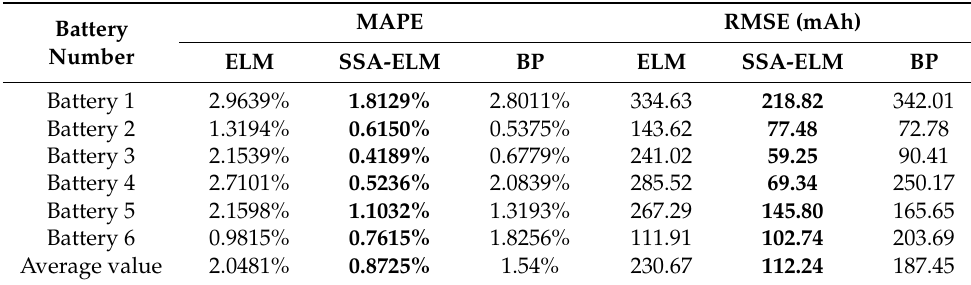
Table 3. Comparison of prediction